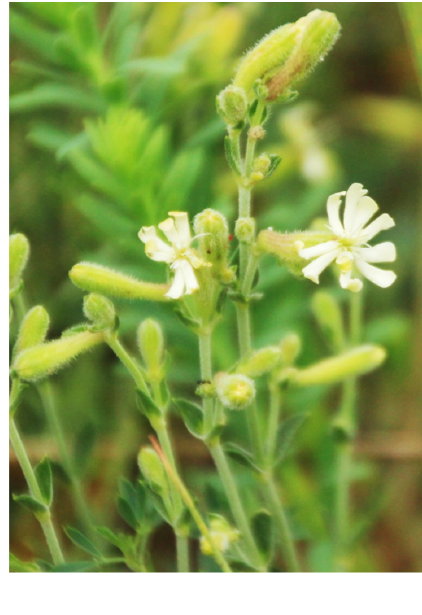
Figure 1. Silene thymifolia (original photo Jianu